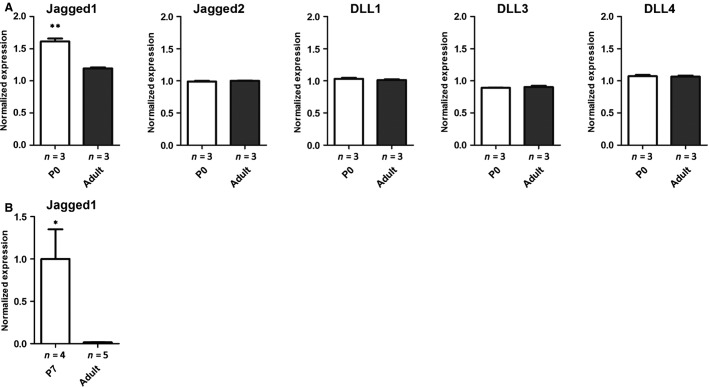
Jagged1 is upregulated in renin cells during neonatal life compared to adult. (A) The expression of all five Notch ligands within renin cells at P0 and adult ages was assessed from a publicly available database (Brunskill et al. 2011) (**P < 0.01, n = 3 for each condition). (B) Quantitative PCR for Jagged1 was performed at P7 and adult ages (*P < 0.05, n = 4 for P7 and n = 5 for adult time points).